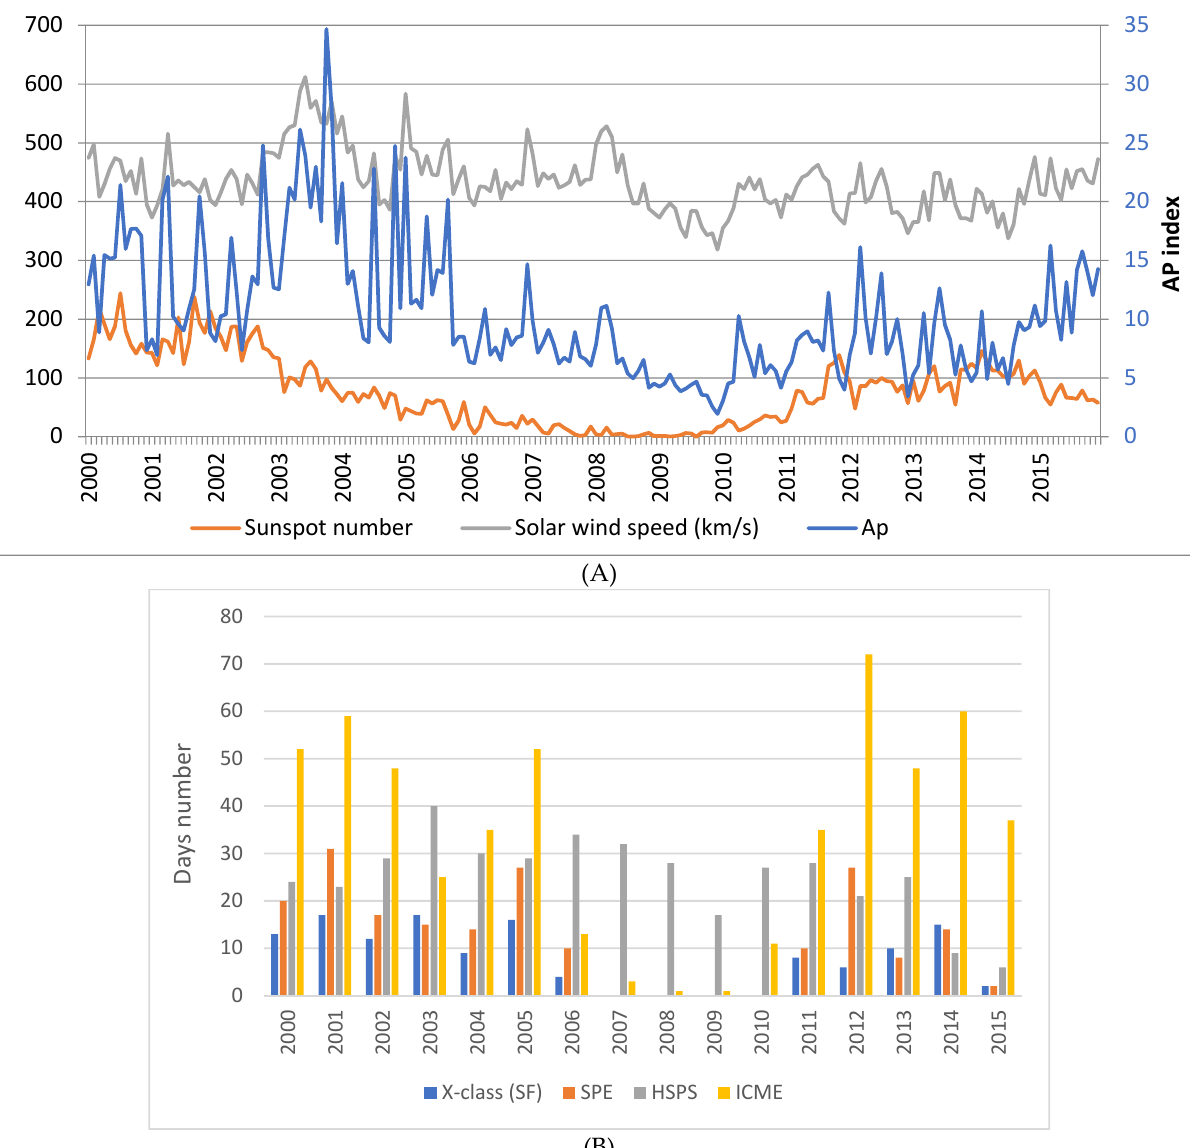
Figure 1. ( A ) The monthly variation in the daily mean sunspot number, solar wind speed, and the Ap index; ( B ) the annual rate of the days of interplanetary coronal mass ejections (ICMEs), solar proton events (SPEs), X-class solar flares (SFs), and high-speed plasma streams (HSPSs).